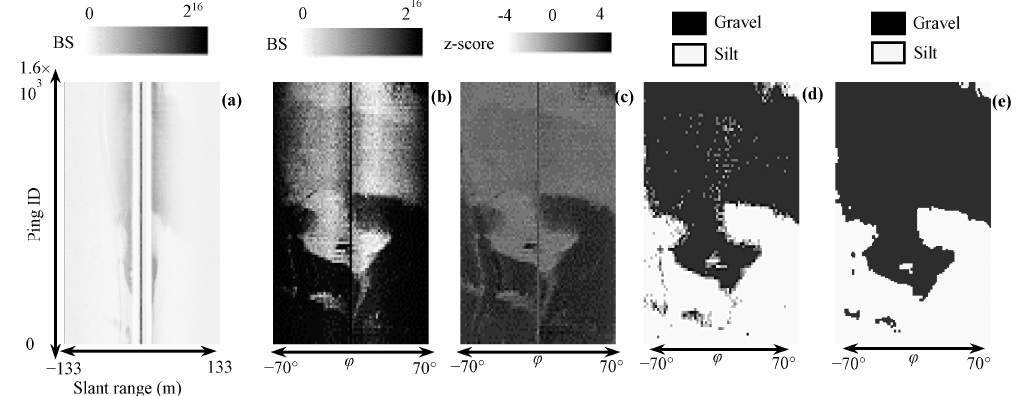
Figure 6. Acquisition of SSS sediment image. ( a ) Raw SSS waterfall image; ( b ) angular image; ( c ) normalized image; ( d ) sediment image; and ( e ) denoised sediment image. φ is the incident angle.